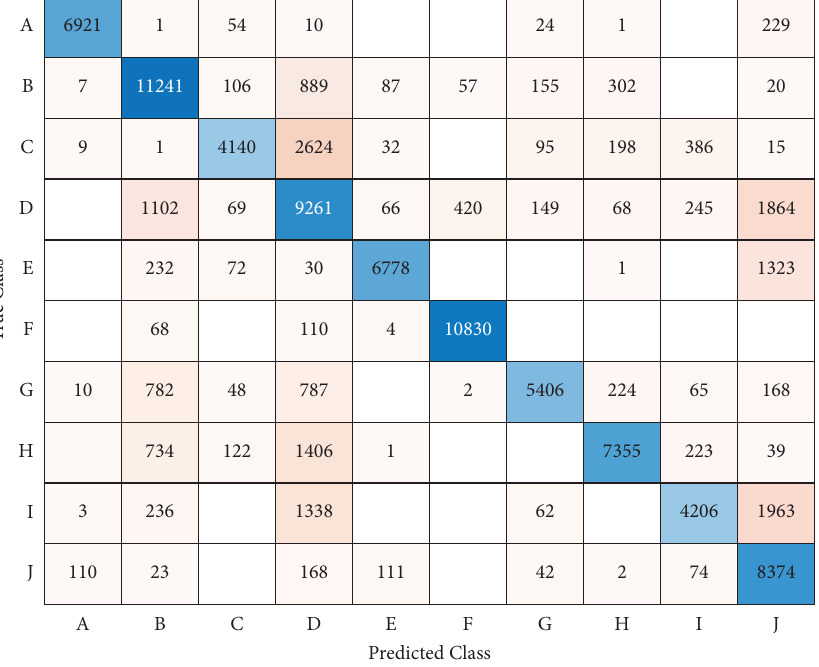
Figure 9: Confusion matrix with predicted class vs. true class for 15-feature model.